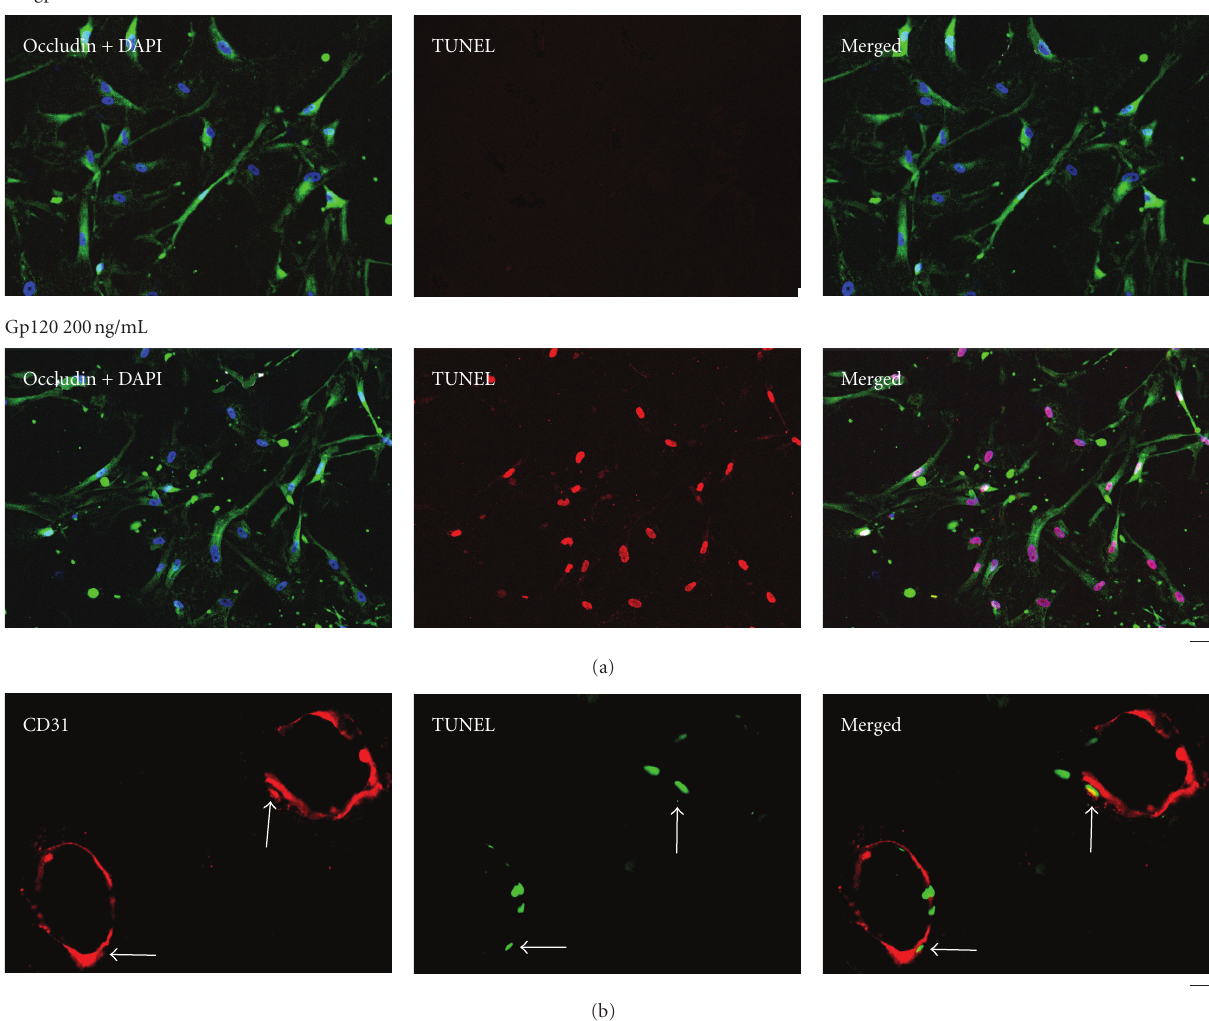
Figure 2: Gp120 is toxic to endothelial cells. (a) Human brain endothelial cells immunostained for occludin and incubated with 200 ng/mL gp120 became apoptotic. The nucleus was immunostained by 4 (cid:2) ,6-diamidino-2-phenylindole (DAPI). Apoptotic cells were assayed by TUNEL. Numerous TUNEL-positive cells were observed after treatment with gp120 while almost no apoptotic cells were seen in cultures that were not incubated with gp120 ( P < 0 . 001 serum-free media (control) versus 200 ng/mL gp120 in serum-free media for 24 hours). Almost all occludin-positive cells were TUNEL-positive for 200ng/mL gp120. Control with bu ff er only and no enzyme showed no TUNEL staining (not shown). (b) Cryostat sections of rat CP injected with 500 ng gp120 1 hour earlier immunostained for CD31 and processed for TUNEL assay. Some of the endothelial cells, immunostained for CD31, are apoptotic and TUNEL-positive (arrows). Bars: (a) 50 μ m; (b) 60 μ